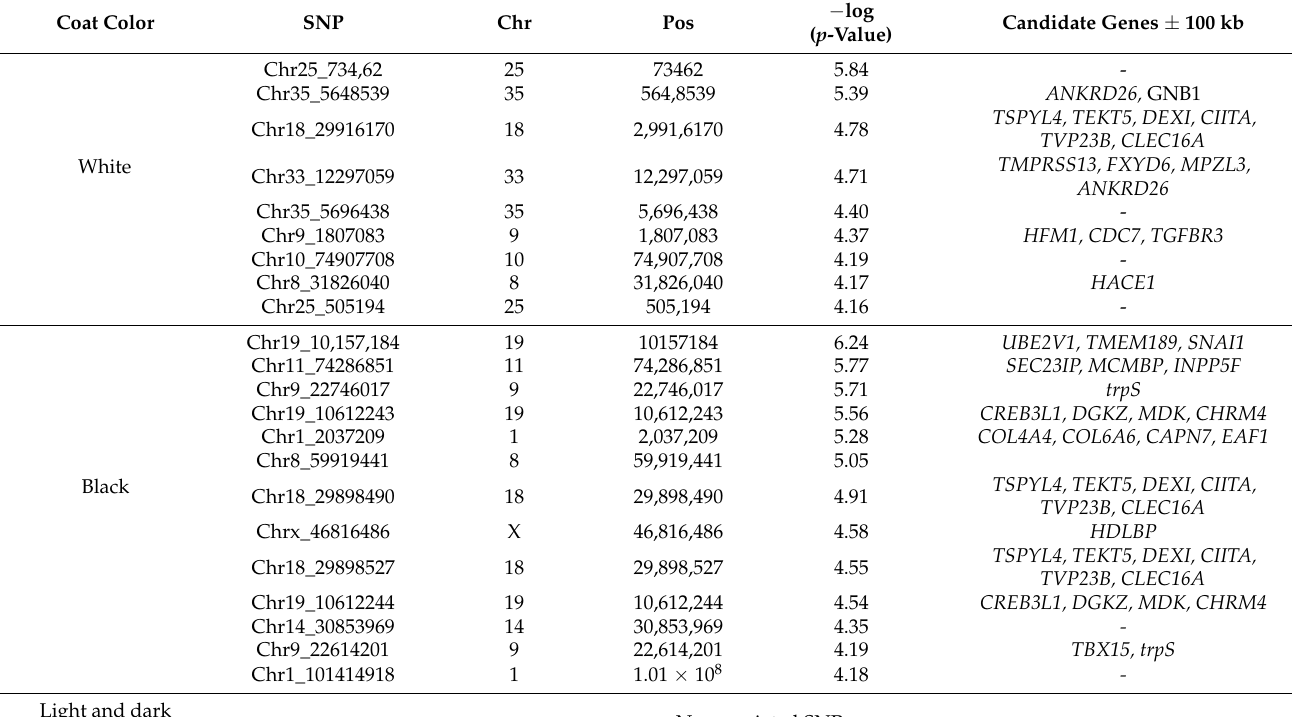
Table 1. The associated SNPs in three case–control GWAS models of coat color in